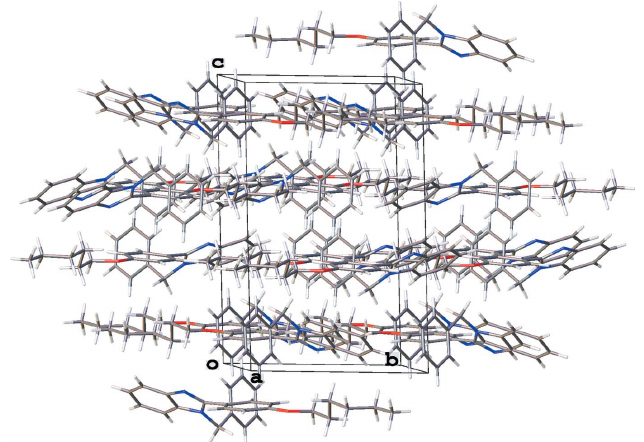
Figure 7 Fragment of the crystal packing of 1 - benzyl-2-(4-hexyloxyphenyl)-1 H - benzimidazole ( 3